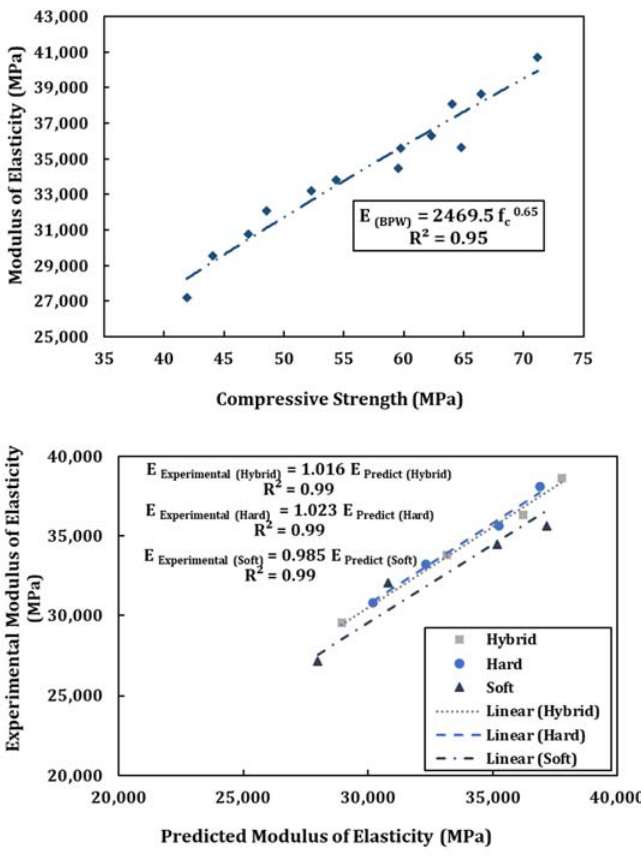
Figure 16. The relation between modulus of elasticity and compressive strength of BPW-containing concrete and correction factors for each type of BPW.